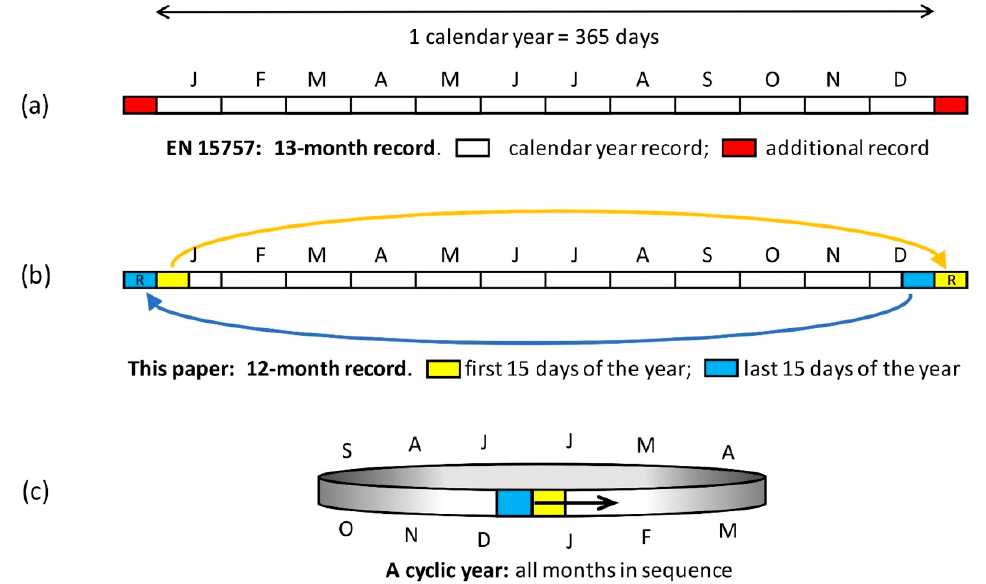
Figure 2. ( a ) The method proposed by EN 15757 requires a 13-month record: i.e., 12 months of the calendar year (white strip) plus two periods of 15 days at both extremes (red rectangles). ( b ) The method proposed in this paper, i.e., 12-month record and repetition of the first 15 days (yellow rectangle) and last 15 days (cyan rectangle) at both ends of the year for calculation purposes. R for ‘repeated’. ( c ) A cyclic year, where all months are in circular sequence with December connected to January.